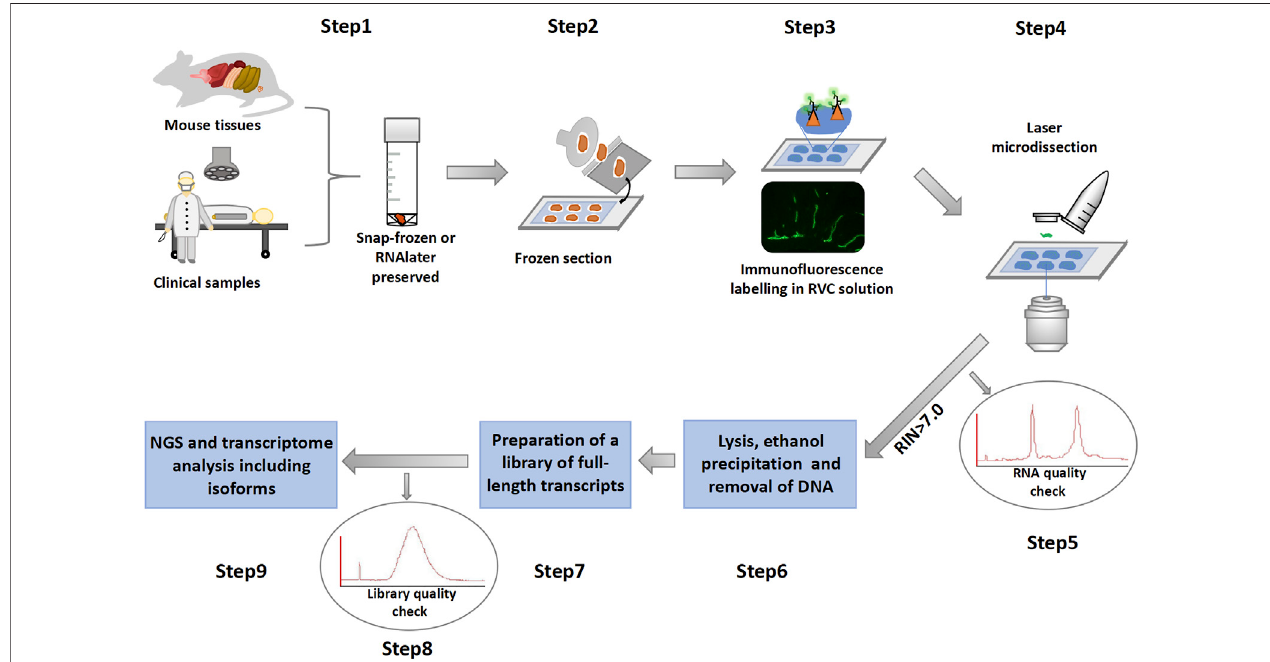
FIGURE 1 | Overview of the immuno-LCM-RNAseq